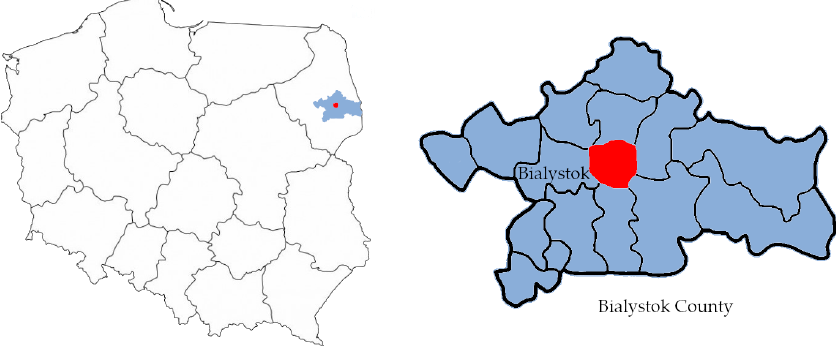
Figure 1. The geographical location of Bialystok and Bialystok County in northeastern Poland.